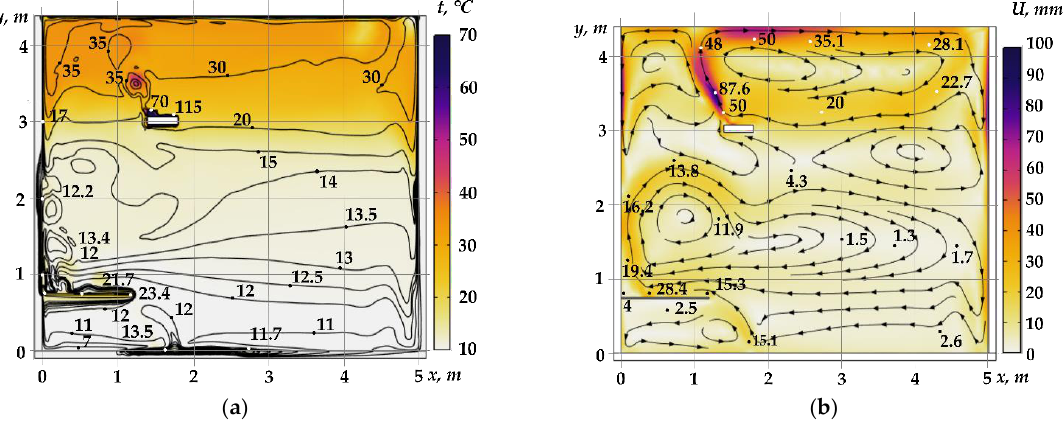
structure, descends along it (Figure 13b). It should be noted that the air temperatures in the area between the right wall and the panel also rise to 13.5 ◦ C.